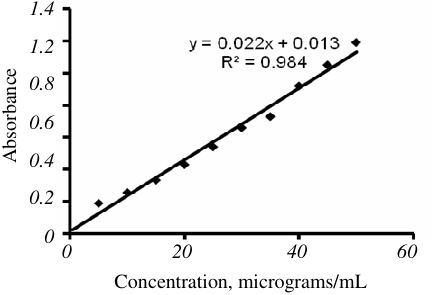
Figure 2. Calibration curve (Method